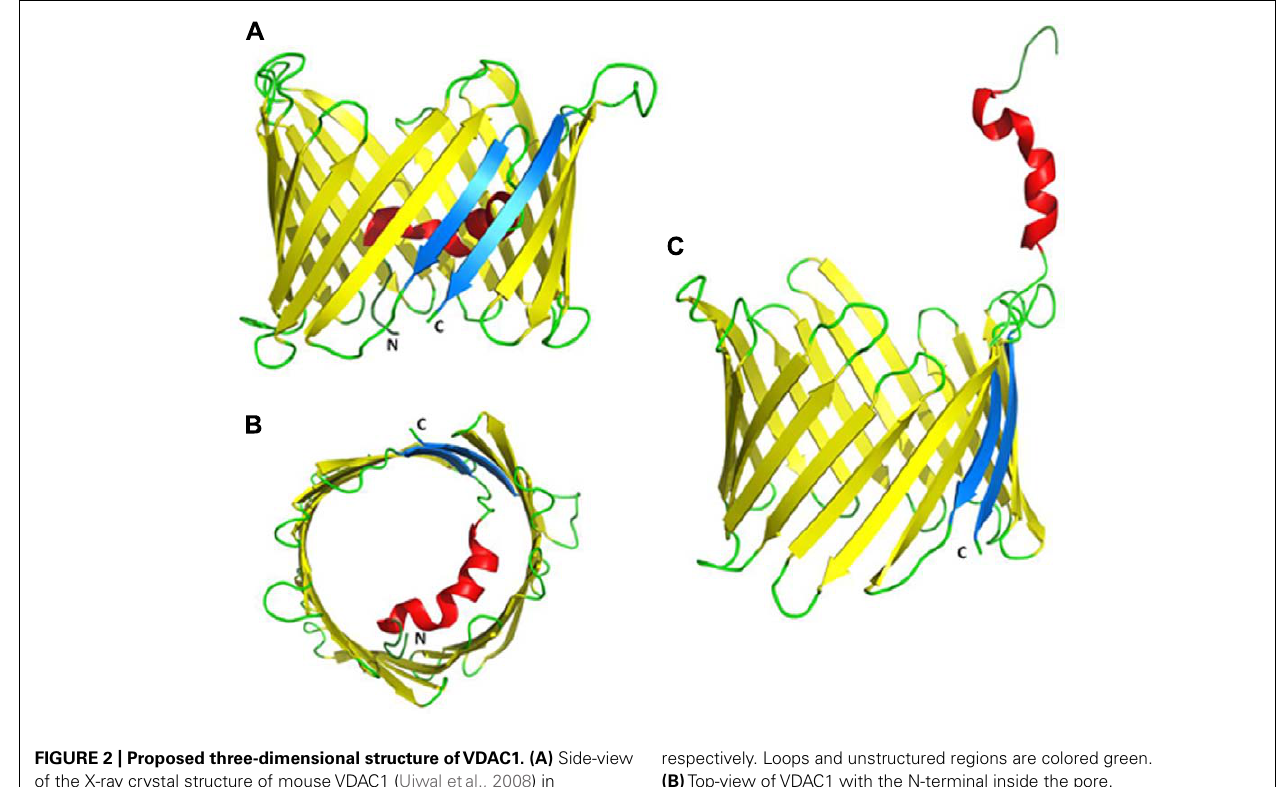
FIGURE 2 | Proposed three-dimensional structure ofVDAC1. (A) Side-view of the X-ray crystal structure of mouseVDAC1 (Ujwal etal., 2008) in a ribbon representation.The β -barrel is formed by 19 β -strands and the N-terminal helix is folded into the pore interior. β -strands 1 and 19 are parallel and colored blue.The C- and N-termini are annotated as C and N,